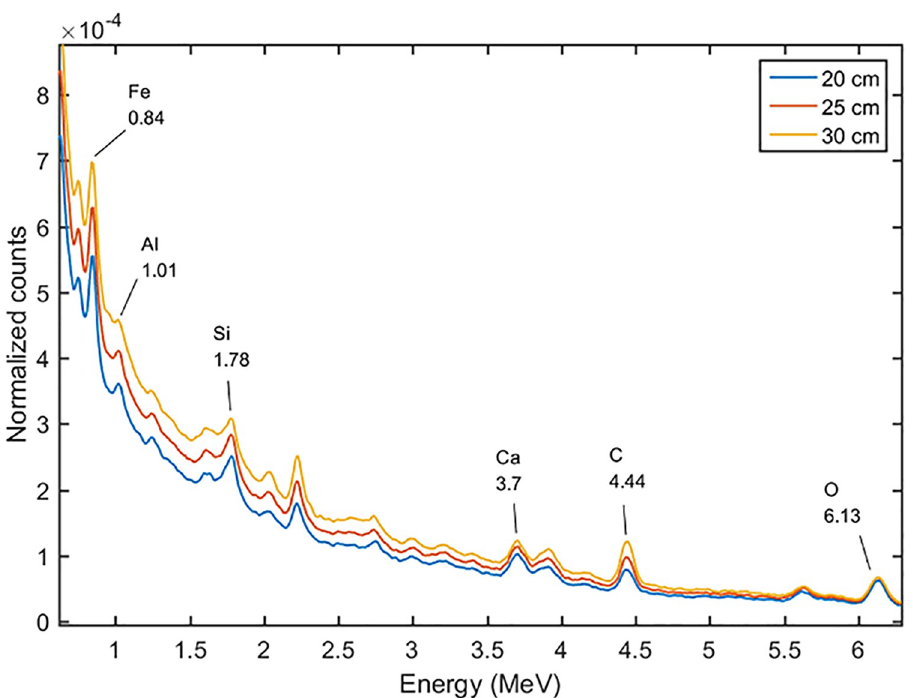
Fig 9. The fast spectra with different